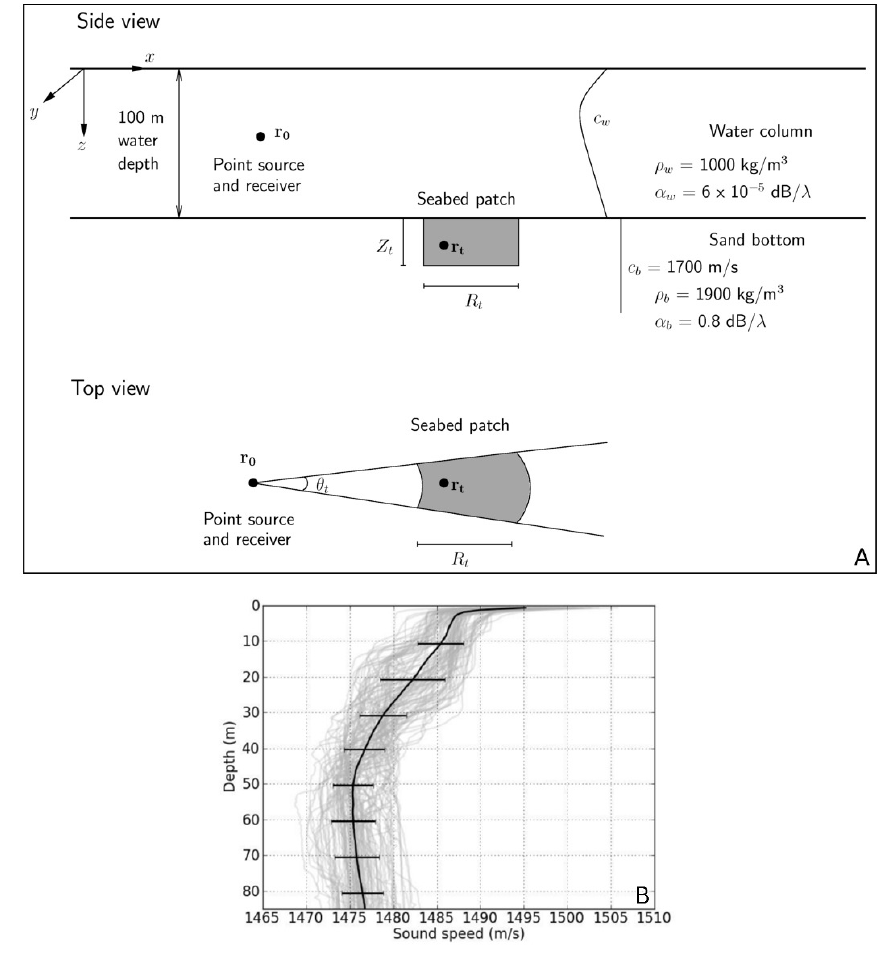
scattered field in a standard Pekeris waveguide of a depth of 100 m for a monostatic point source-receiver located at the mid-water column. The total moments of the scattered field are calculated for a sector of an ocean bottom or seabed patch, extending over range R Z and azimuth θ , containing volume inhomogeneities. The scattered field from the patch t t then effectively corresponds to the scattered field level measured from a given direction if a receiver array with an angular beamwidth of θ density and attenuation in the water column and in the sand bottom are c α , respectively, and ( B ) sound speed profiles measured on the New Jersey continental shelf b (gray) are used for the simulations. The solid black line and horizontal tick marks indicate the mean sound speed profile and the standard deviations, respectively